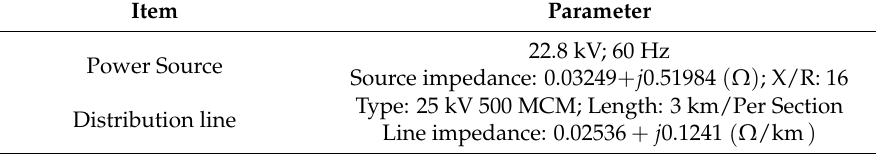
Table 1. Test system parameters.